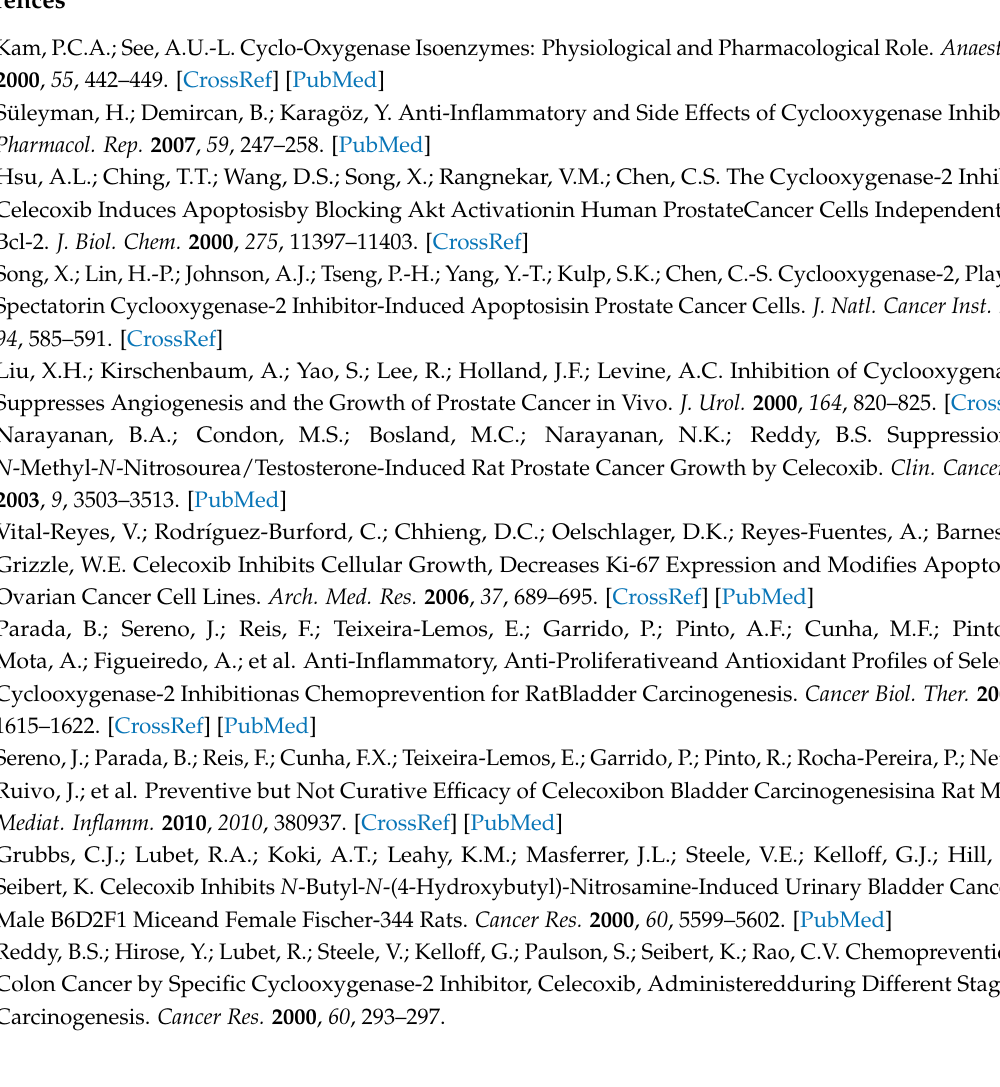
Table S1: Results and biological activity for the COX-1 and COX-2 docking study. Figure S4. An overview of the docking positions for PS33 (light blue), PS43 (magenta) and PS35 (yellow) under the COX-1 and COX-2 binding conditions. The flurbiprofen (red) shows facilitation of the orientation in the binding cavity. Figure S5. Docking poses of PS33 (blue) and PS43 (magenta) under COX-1 and COX-2 binding domain conditions. Ligand maps representing interactions by hydrogen bonds (blue dot line); details are given in the main